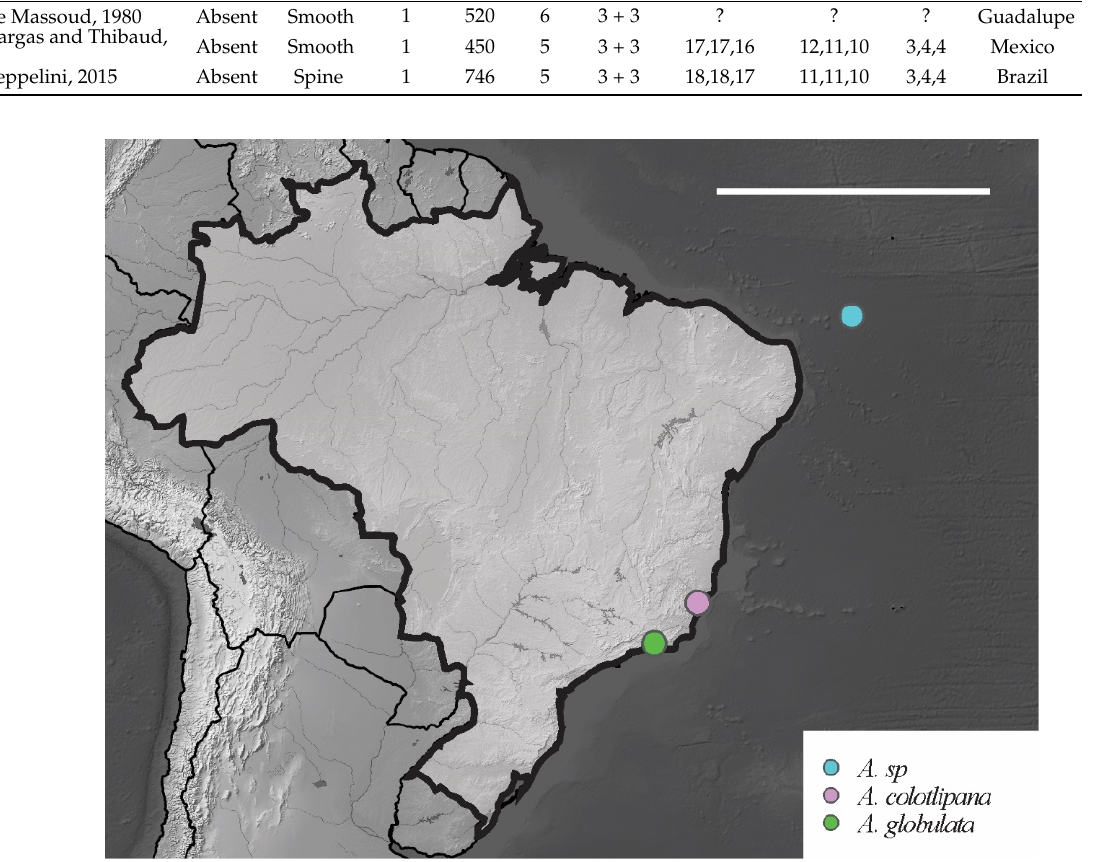
Figure 14. Distribution map for Acherontiella Absolon, 1913 species recorded in Brazil. Scale bar: 3000 km.